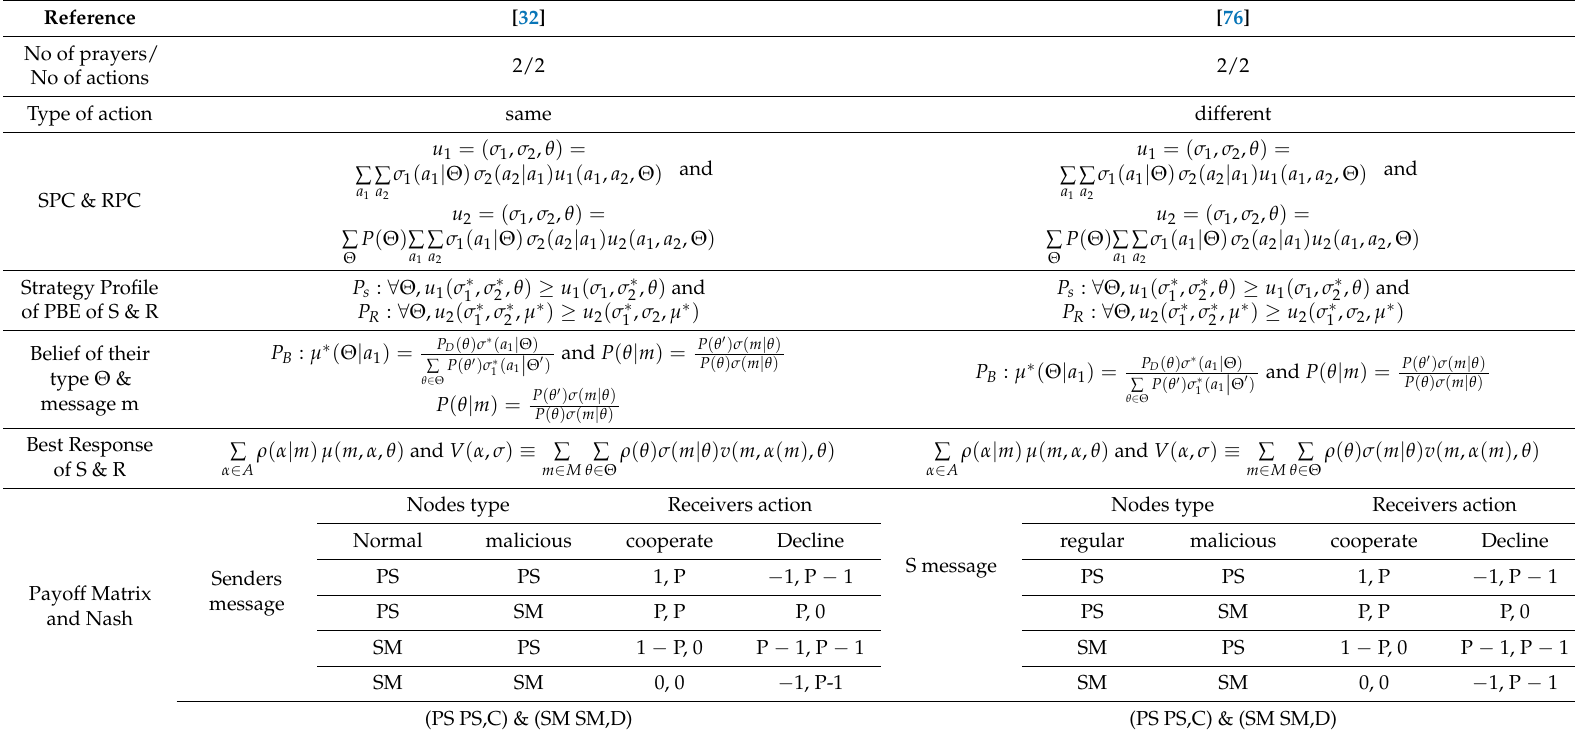
Table A2. Mathematical Comparison of Dynamic Bayesian